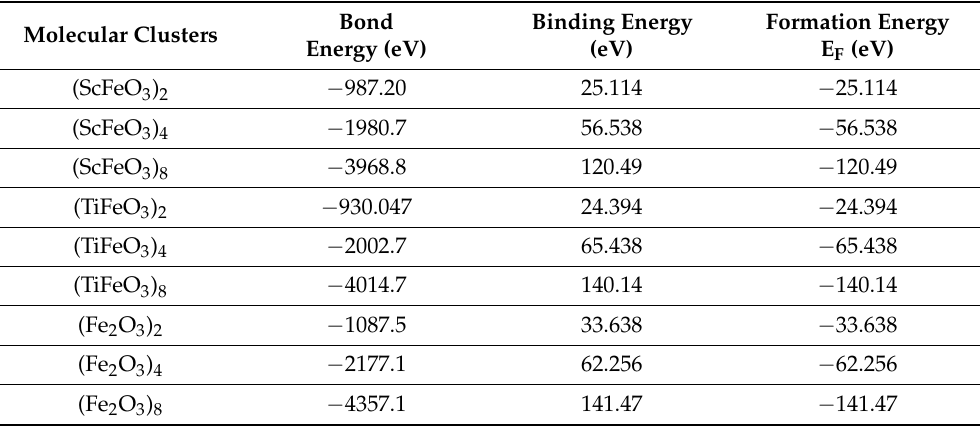
Table 1. This Table Explains Tabular form of Spin, Total Optimized Energy, Fermi Energy at Opti- mized Energy, Binding Energy, and Formation Energy for all Calculated Clusters.